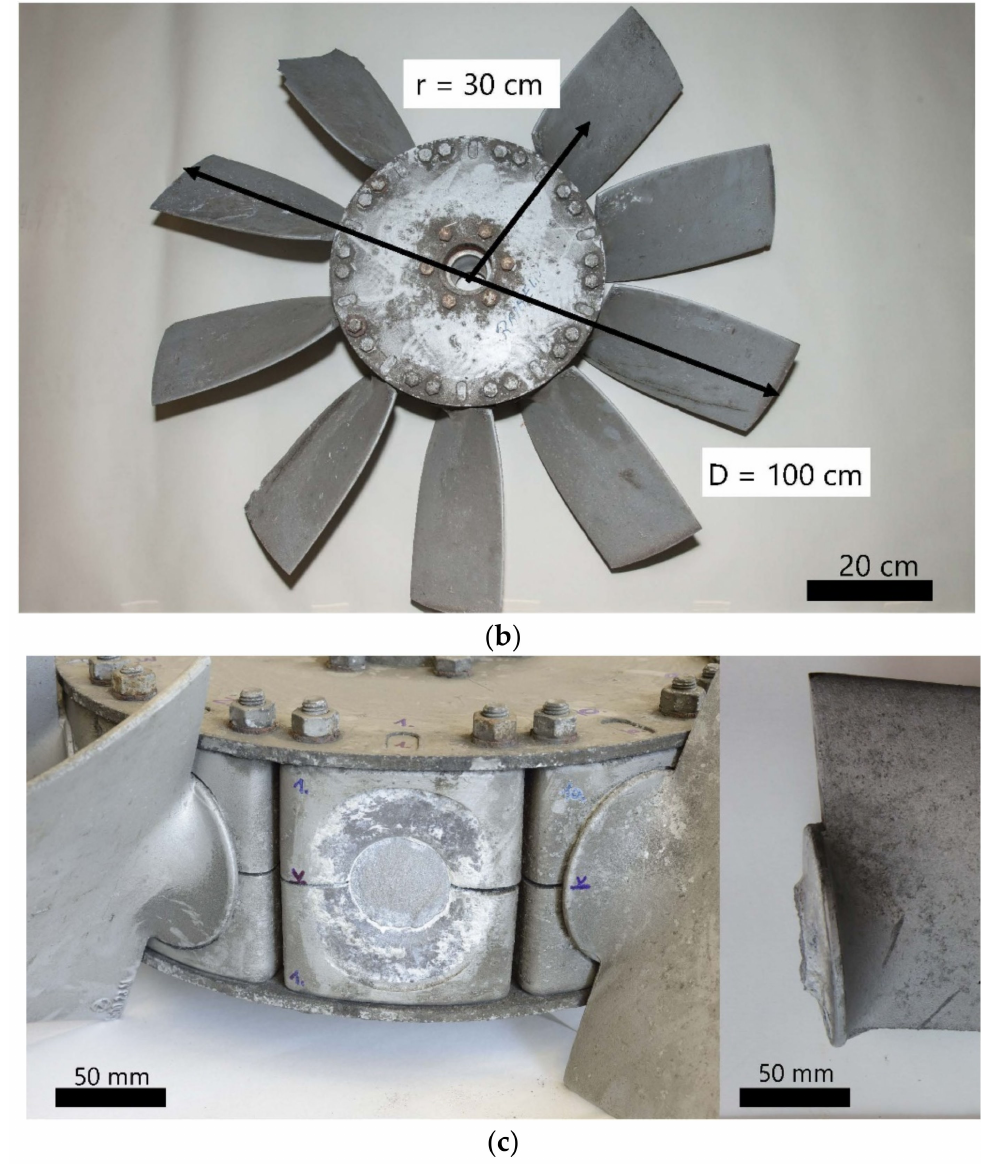
Figure 1. Ventilation system and broken blade: ( a ) installation in the tunnel, ( b ) rotor with a broken blade, and ( c ) fractured section in the broken